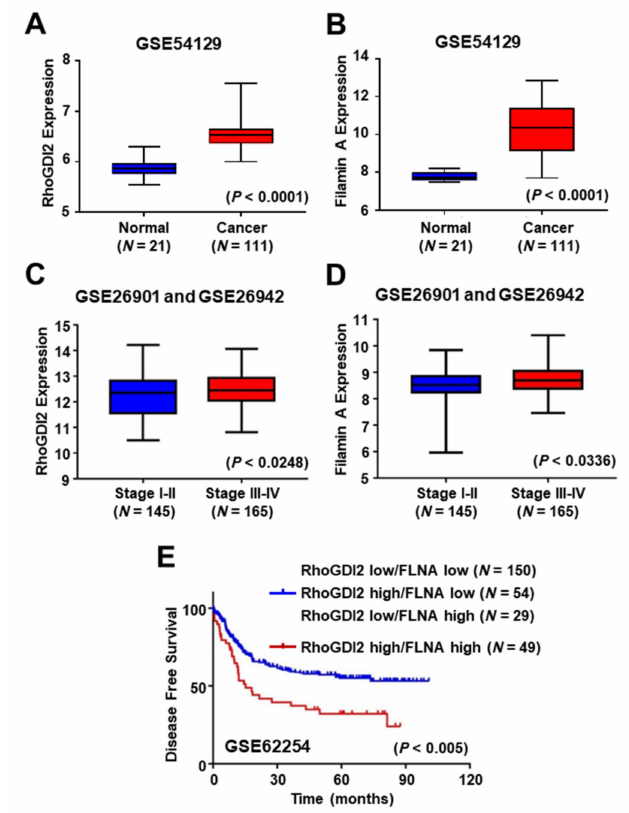
Figure 5. Expression of RhoGDI2 and Filamin A could be poor prognostic markers in gastric cancer patients. ( A , B ) Comparison of RhoGDI2 ( A ) and Filamin A ( B ) expression levels between normal and gastric cancer patient tissues from the GEO data set (GSE54129). The interquartile range is shown by the boxes, the median is represented by the center, and the whiskers represent the minimum and maximum values. The unpaired, two-tailed Student’s t -test was used to calculate p -values. ( C , D ) Comparison of RhoGDI2 ( C ) and Filamin A ( D ) expression levels in different stages of gastric cancer patients from GEO data sets (GSE26901 and GSE26942). The interquartile range is shown by the boxes, the median is represented by the center, and the whiskers represent the minimum and maximum values. The unpaired, two-tailed Student’s t -test was used to calculate p -values. ( E ) Correlation of RhoGDI2 and Filamin A expression levels with disease free survival in 282 gastric cancer patients using a publicly available microarray data set (GSE62254). A Kaplan–Meier plot analysis showed disease free survival depending on the expression level of both RhoGDI2 and Filamin A. A log-rank test was used to calculate p